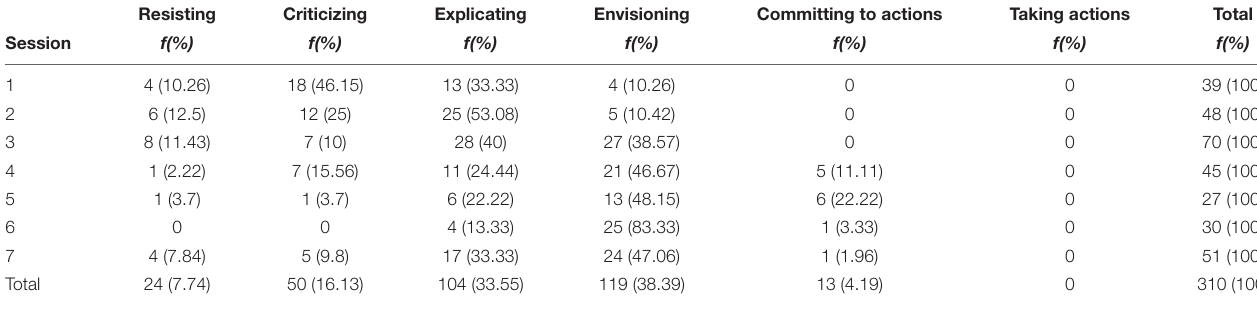
TABLE 3 | The expression types of transformative